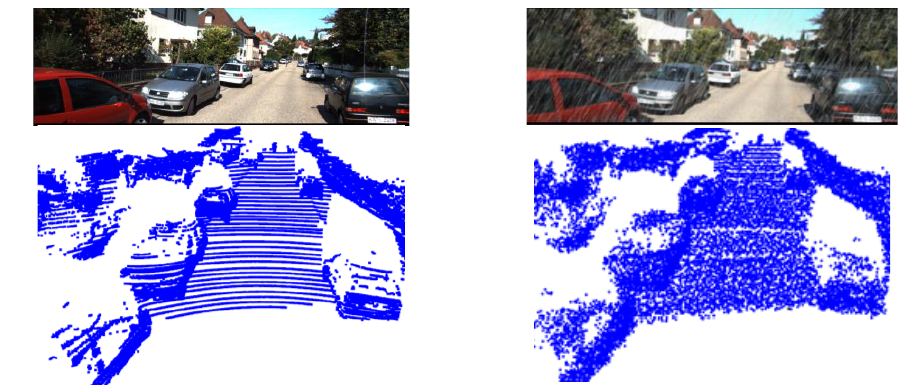
Figure 6. The effect of adding rain noise to the data.